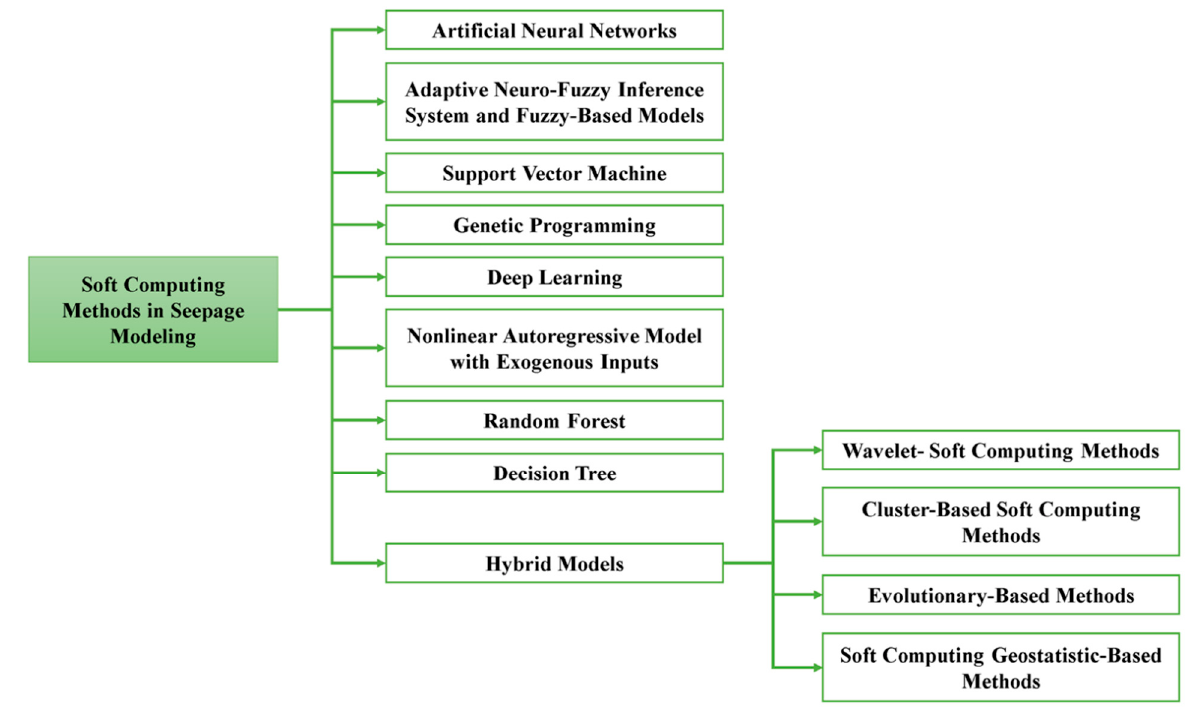
Figure 3. Taxonomy of the review, soft computing methods in seepage modeling. Table 1. Details of the reviewed papers about application of soft computing methods in seepage modeling.